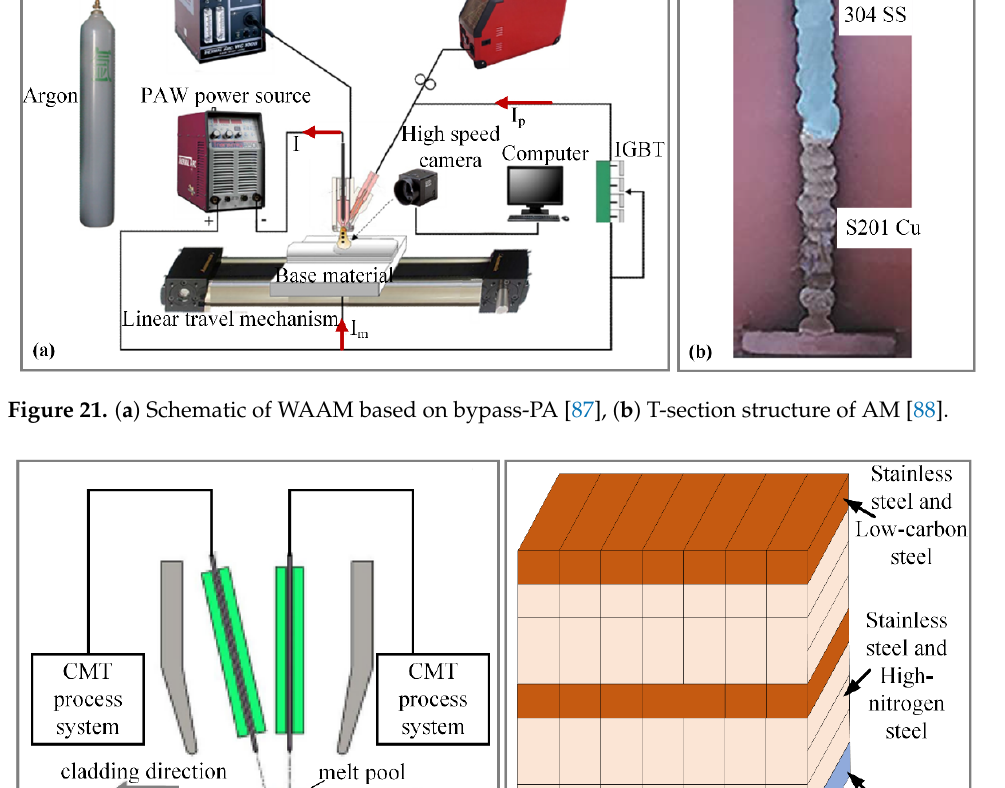
Figure 23. Schematic of FGMs by PA-AM [92]. Figure 24. ( a ) Schematic for the distribution of layers, ( b ) Cross section and microstructure of layer structure [93]. It can be seen from the above studies that, although the FGMs prepared by WAAM present different gradient types, the components in each cladding layer are evenly dis- tributed. The authors carried out a systematic study on the properties of a twin-body plasma arc [94–96], and the results showed that the heat input of the substrate reduced